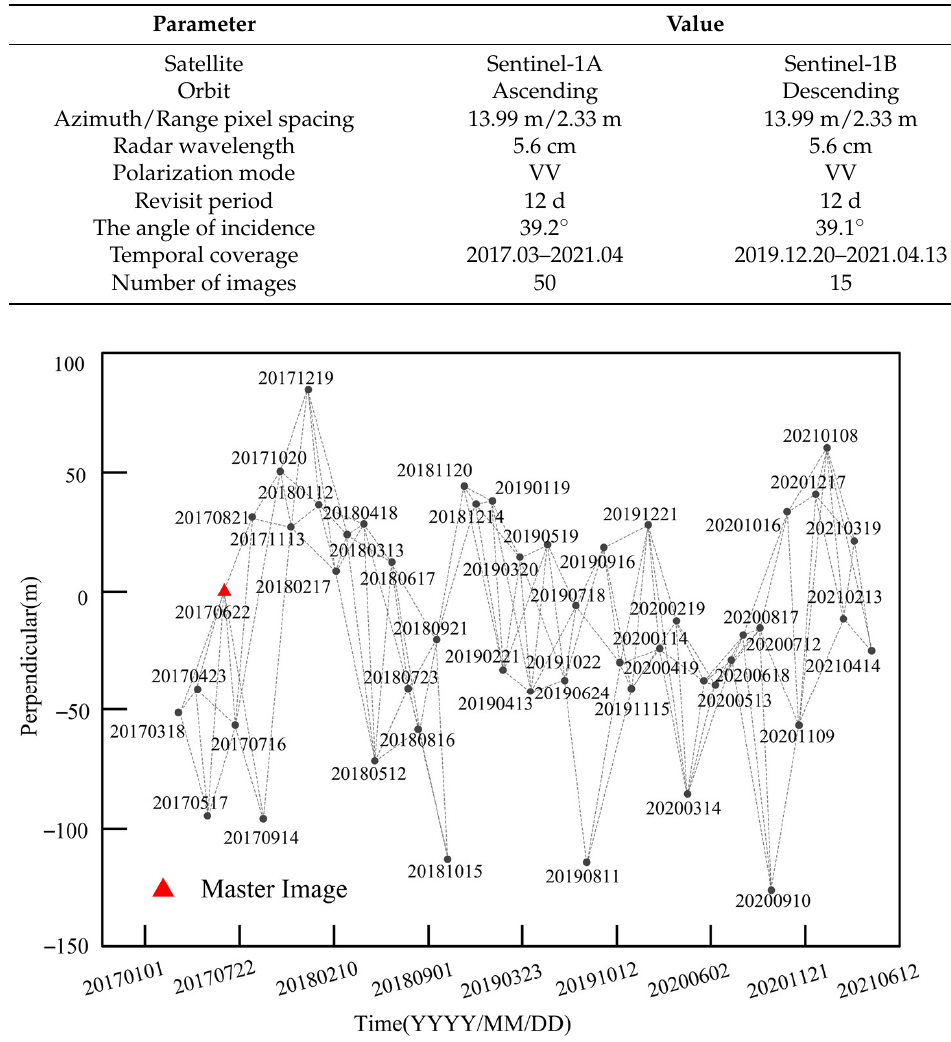
Figure 3. Spatial and temporal baselines of Sentinel-1 ascending data.